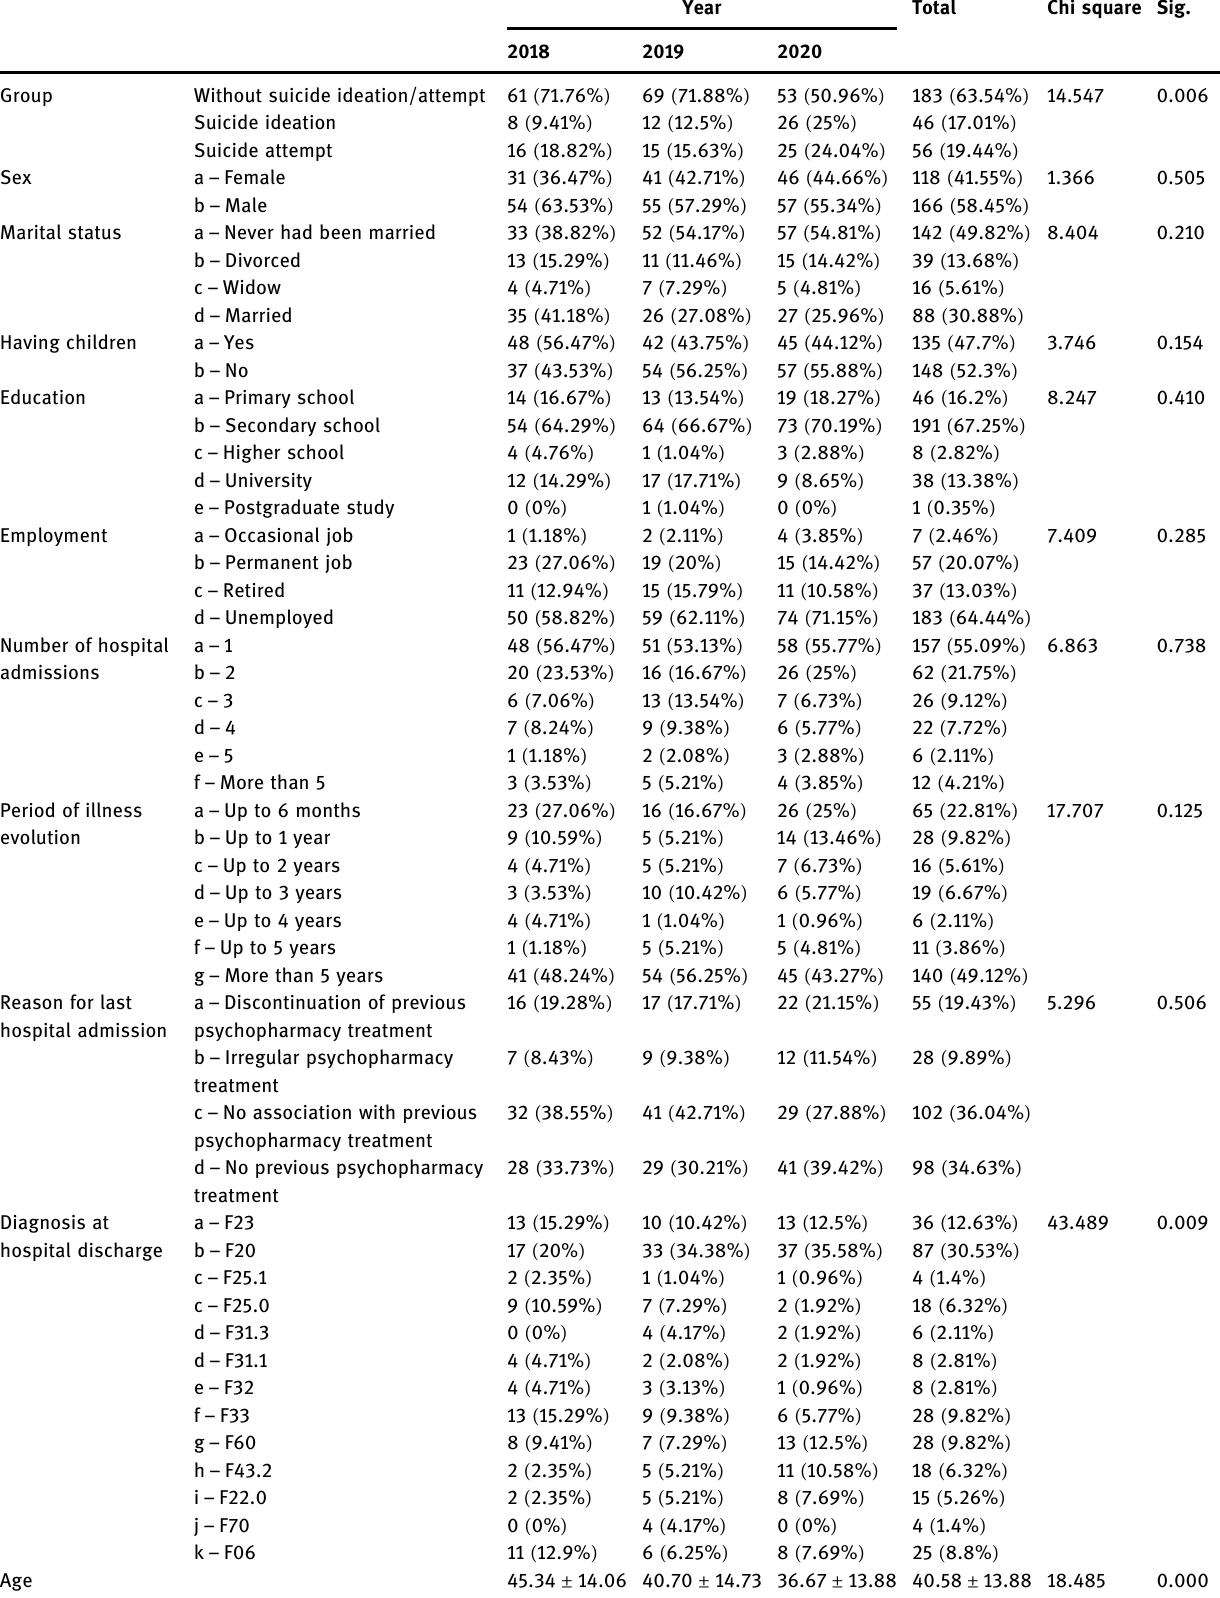
Year Total Chi square